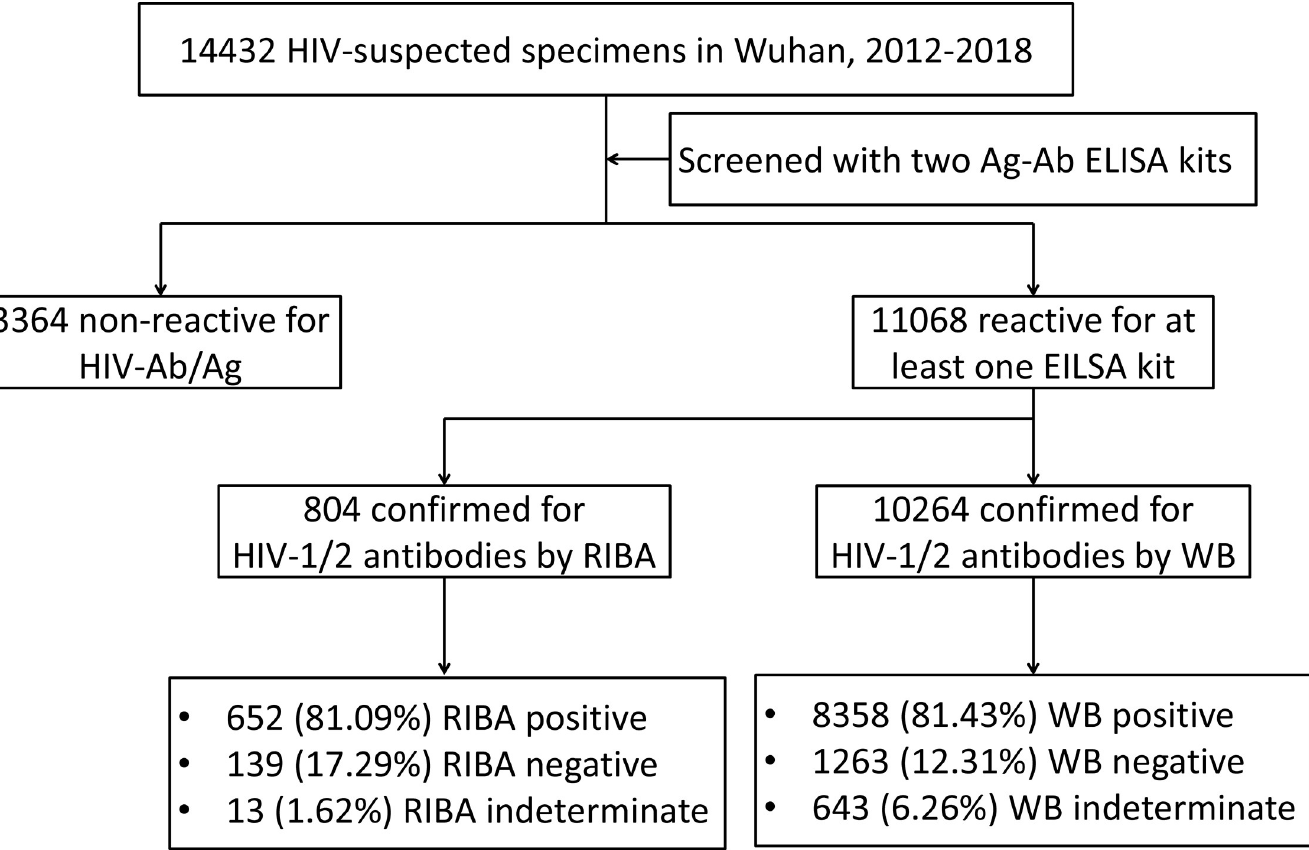
Fig 1. Flowchart of data collection for the comparison of WB and RIBA tested for HIV-1 infection in Wuhan, 2012–2018. Due to the unexpected procurement result, RIBA-WANTAI was used for HIV confirmatory test from July 1, 2014 to January 7, 2015, and WB-MP was used for other times. Two HIV confirmatory tests were significantly different in HIV detection rate, while WB had identified more HIV-1 indeterminate specimens than RIBA. Abbreviations: HIV, Human immunodeficiency virus; WB, western blot; RIBA, recombination immunoblot assay; ELISA, enzyme-linked immunosorbent assay; Ab, antibody; Ag, antigen.